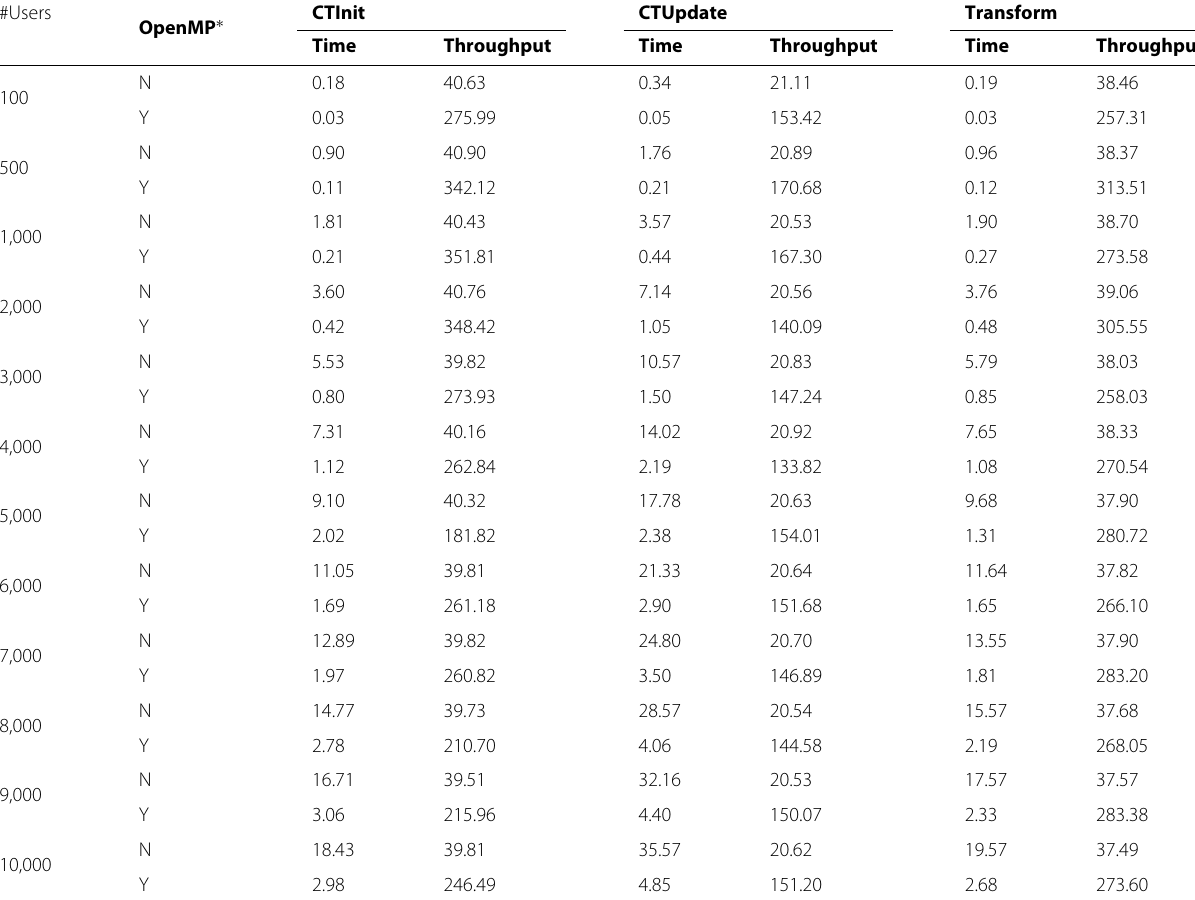
Table 4 Performance evaluation of the